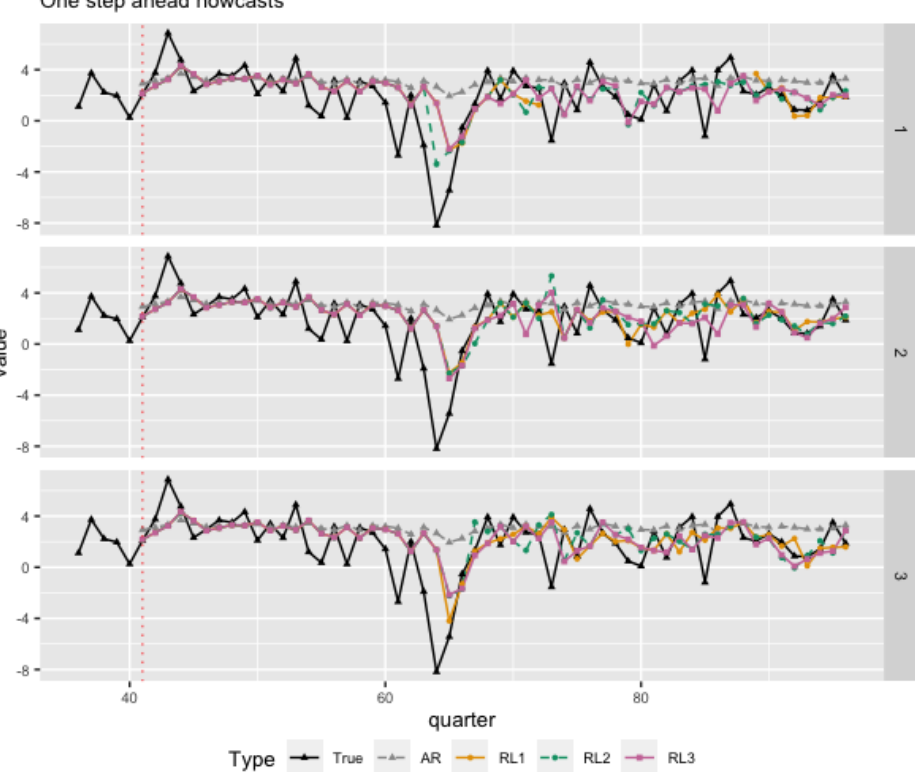
Figure 9. Nowcasting over 2003Q1 to 2016Q4. Three rows represent three nowcasting months, respectively. Black curve represents the real GDP, while curves of different colors and shapes represent nowcasting results from 3 different release dates and